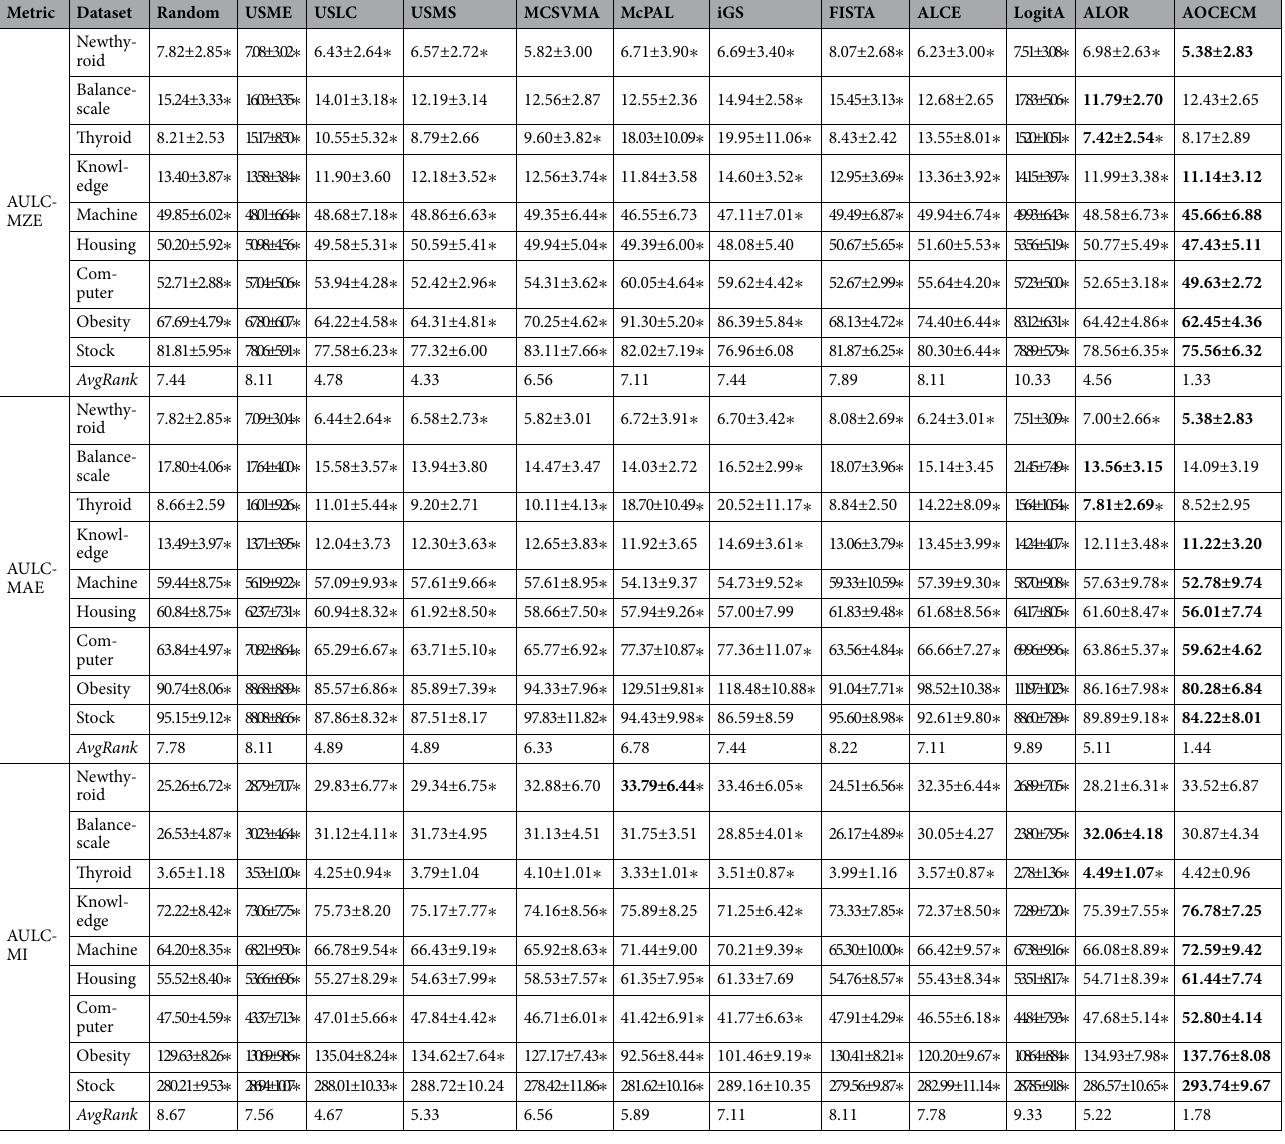
Table 2. Results of AULC-MZE , AULC-MAE, and AULC-MI for the twelve compared methods on the nine datasets.